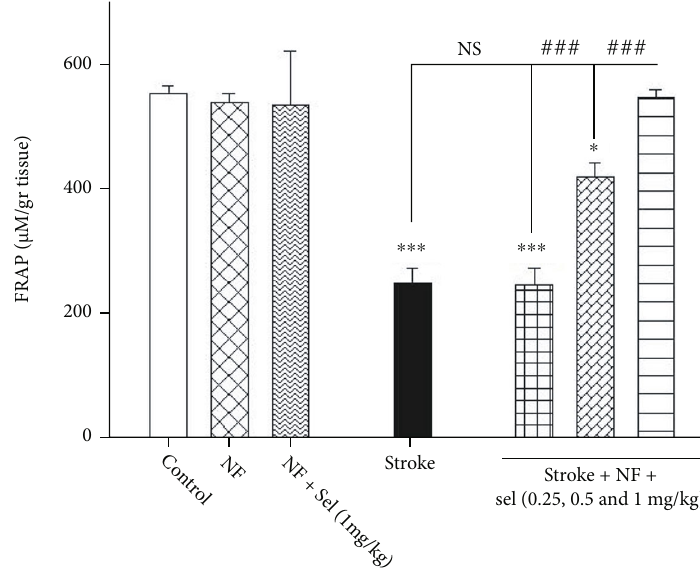
Figure 11: E ff ects of selegiline on FRAP level in the brain. Values are expressed as the mean ± SD and were analyzed using one-way ANOVA followed by Tukey ’ s post hoc test ( n = 3 ). ∗ P < 0 : 05 , ∗∗ P < 0 : 01 , and ∗∗∗ P < 0 : 001 compared with control group. # P < 0 : 05 and ## P < 0 : 01 and ### P < 0 : 001 compared with transient global ischemia rats. “ NF = nanoformulated containing NBP; NF+sel = nanoformulated containing NBP+selegiline.